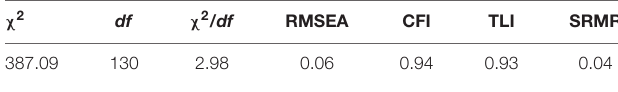
TABLE 1 | School engagement model fitting